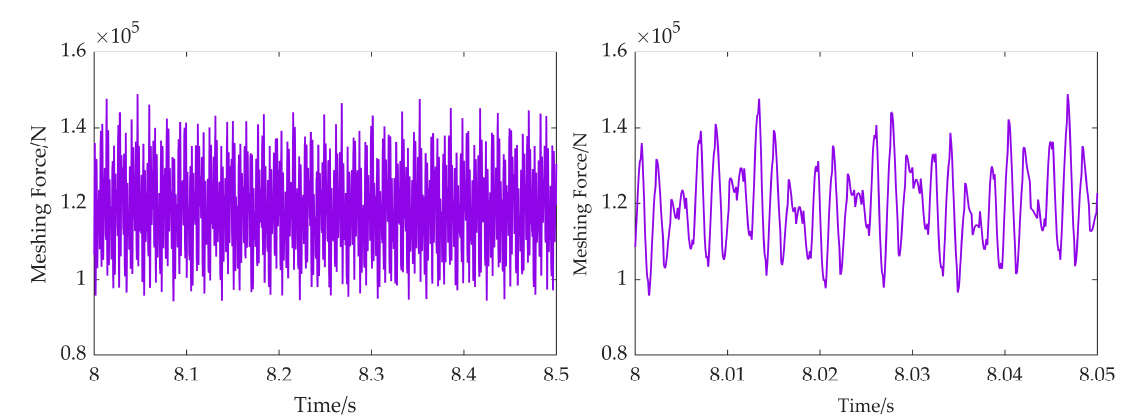
Figure 12. Meshing force between the sun and the three planet gears of the HSP.